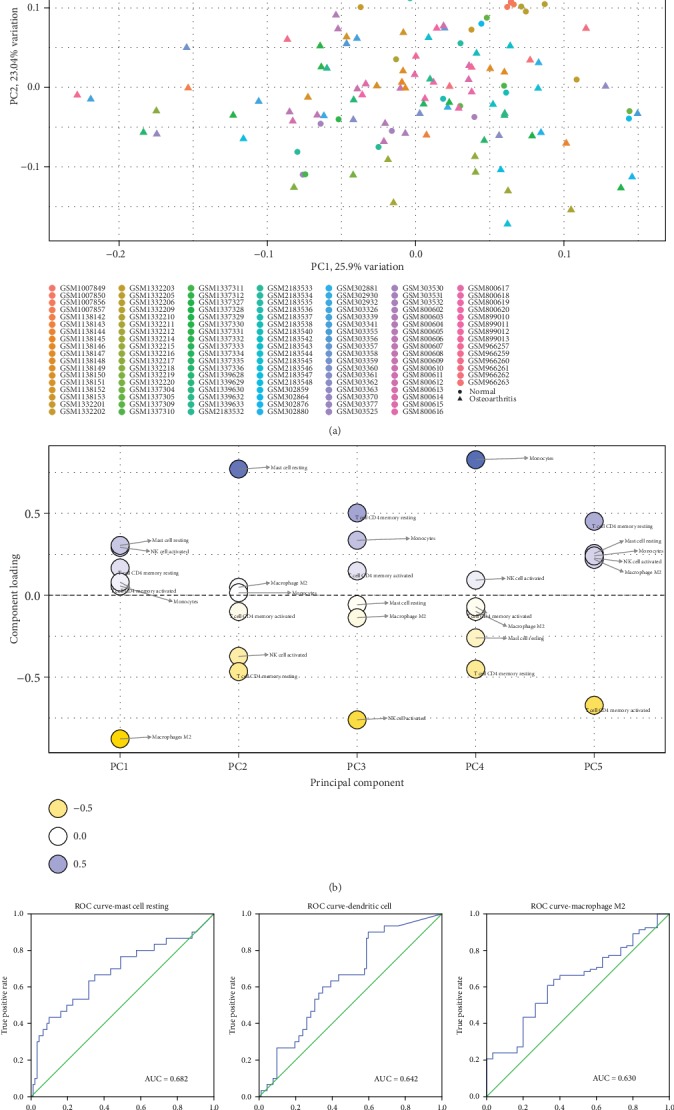
The diagnostic value of composition of infiltrating immune cells for osteoarthritis in synovial tissue. (a) Principle component analysis (PCA). (b) Component loading in PCA results. (c) Receiver operating characteristic analysis.